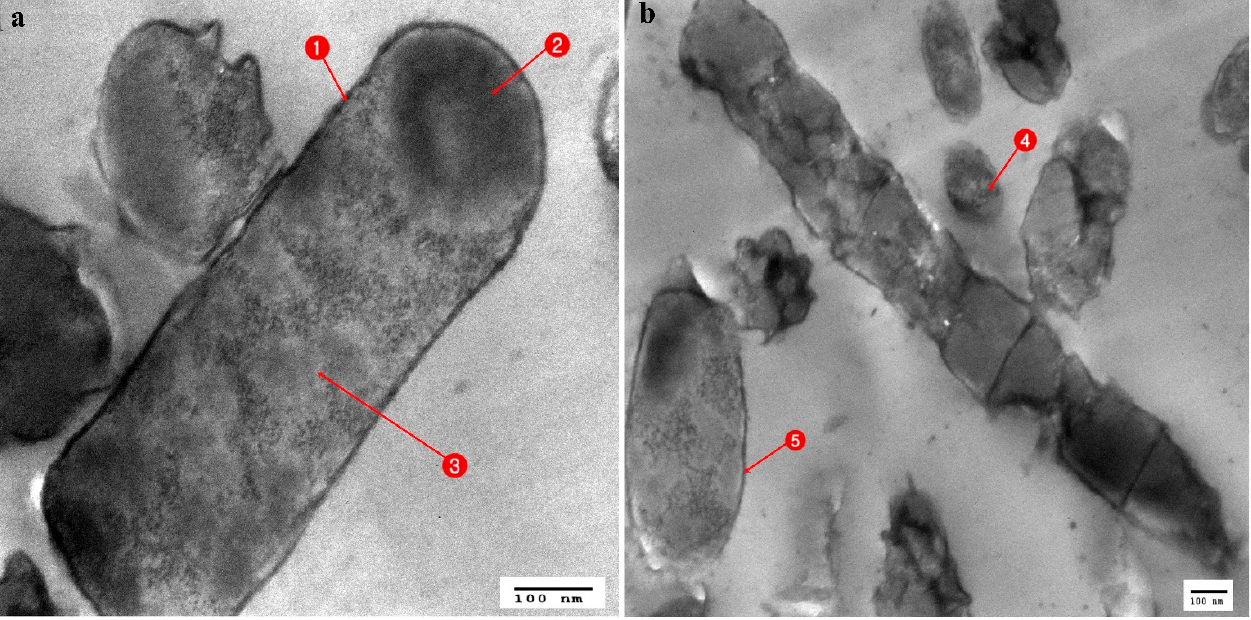
Figure 5. TEM micrograph of Enterobacter cloacae ; ( a ) Normal cells: 1. Cell wall, 2. Nucleic acid material, 3. Uniform cytoplasm; ( b ) cell affected with Serratia marcesens : 4. Precipitation with cytoplasm, 5. Rigid and irregular cell wall.